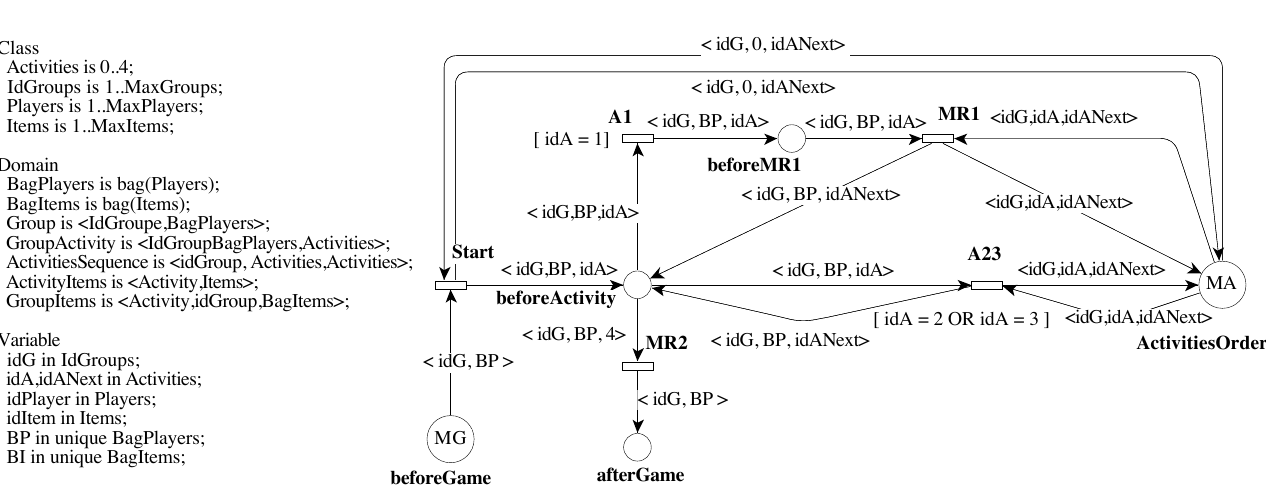
activity is performed in mutual exclusion 1